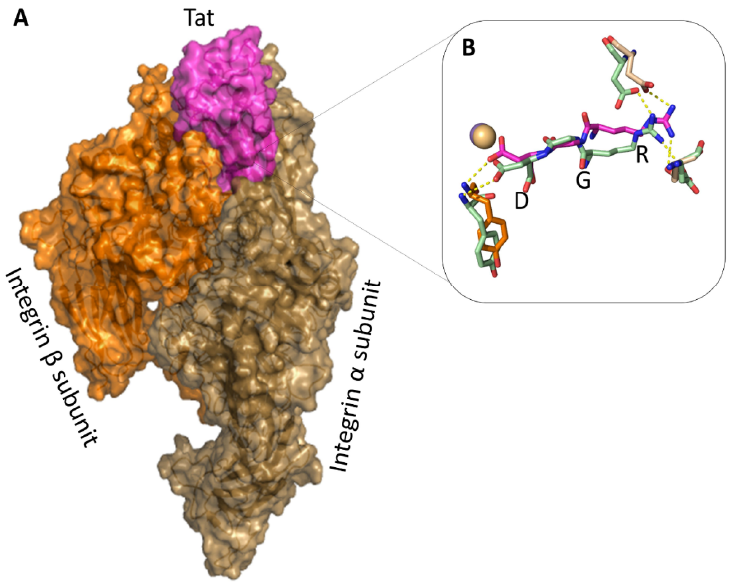
Figure 5. Tat makes contacts with both the α and β chains of αvβ3. ( A ) Average structural model of the Tat–αvβ3–integrin complex structure. Tat (magenta) interacts with both integrin subunits (brown = α; orange = β). ( B ) The calculated structural model of the αvβ3–Tat protein complex (magenta) is compared to the experimental structure of the αvβ3–RGD containing cyclic peptide complex (light green). Conserved hydrogen bonds between the two structures are shown. The metal ion interacting with the RGD fragment is represented as a sphere.